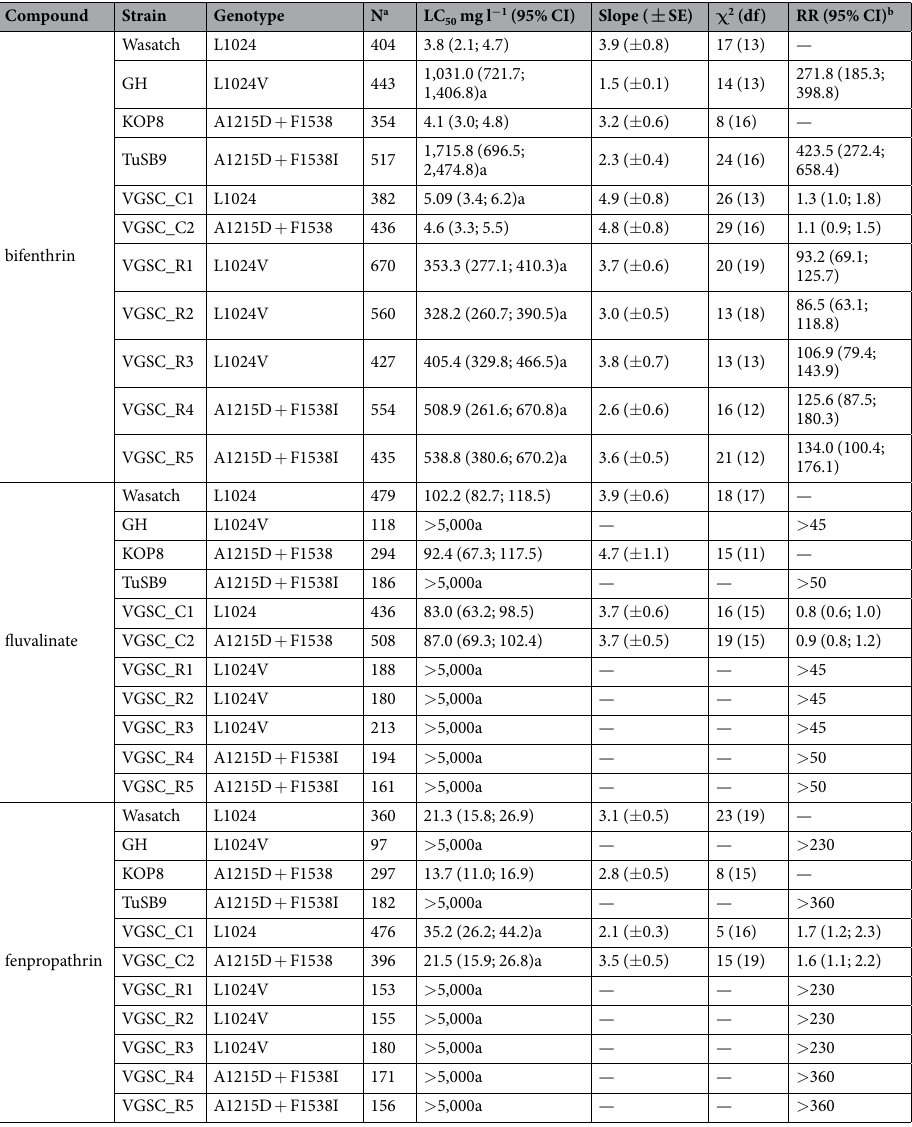
Table 2. Toxicity of pyrethroids (bifenthrin, fluvalinate and fenpropathrin) to adult females of backcrossed lines VGSC_C1, VGSC_R1-R3 (L1024V genotype), VGSC_C2, VGSC_R4,5 (F1538I + A1215D genotype) and their parental strains (Wasatch, GH, KOP8, TuSB9). a Number of mites used in toxicity tests. b RR compared to Wasatch in case of GH, VGSC_C1 and VGSC_R1-3 or KOP8 in case of TuSB9, VGSC_C2 and VGSC_R4,5 lines. a: Treatment effect was significantly different when compared to Wasatch or